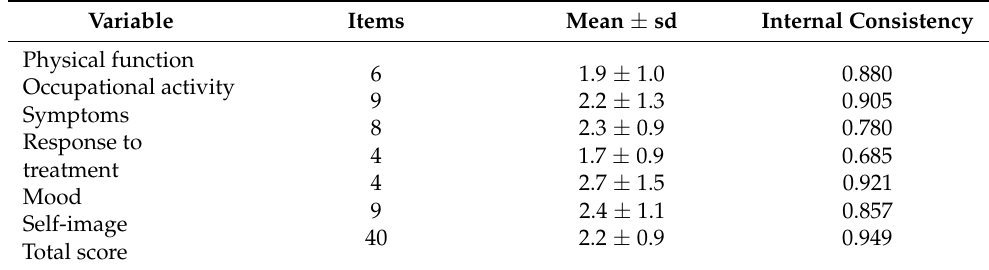
Table 3. SLEQoL internal